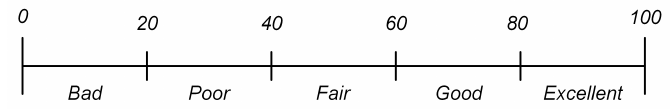
Figure 10. Continuous quality scale provided for the subjective